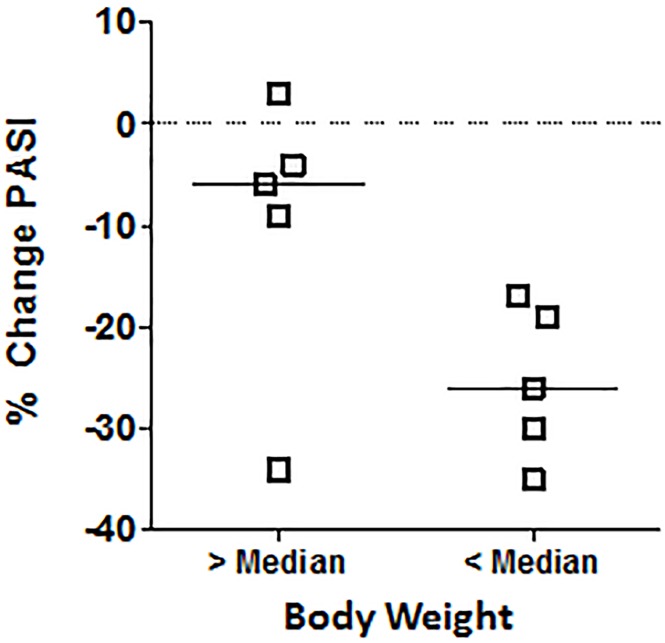
Percent change in PASI score.Change in PASI score for 60 mcg/dose group based on body weight above the median or below the median. Bars indicated mean % change in PASI.